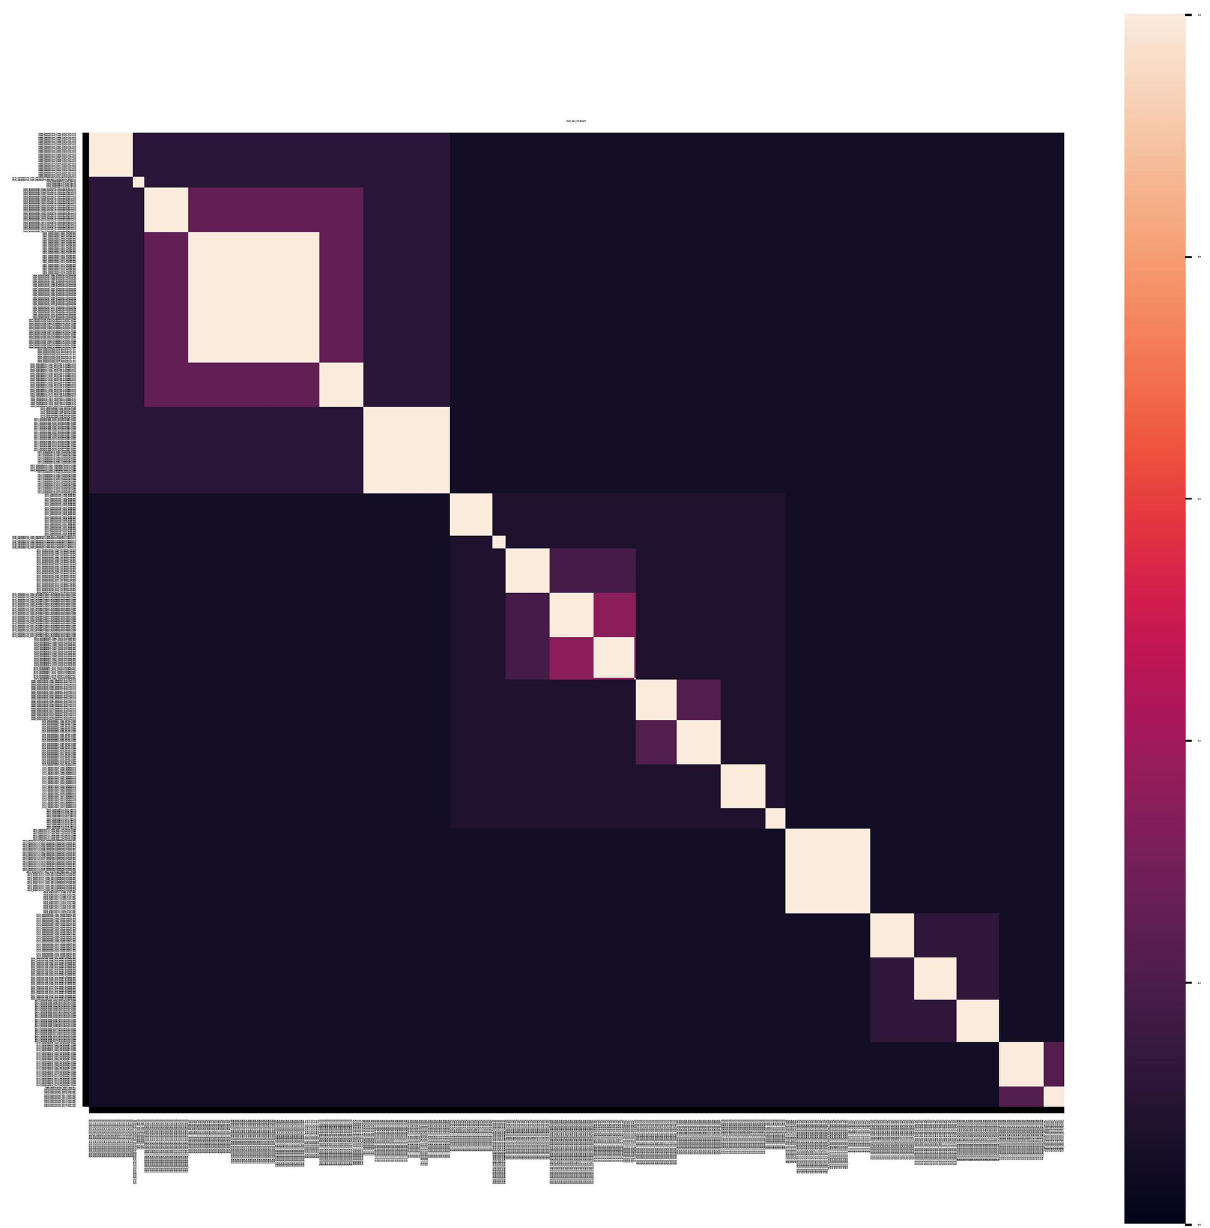
Fig 4. Heatmap of the similarity matrix among twenty years of products products by the firms in the DJIA. Rows (columns) of firms are ordered first by their 4-digit SIC Codes, and then by the CIK of each firm. The white squares along the diagonal show that pairs of documents with the same SIC Code are interpreted as having perfect similarity, and the fainter rectangles falling away from the white squares show that pairs of firms from coarser- grained SIC groups have a uniform intermediate degree of